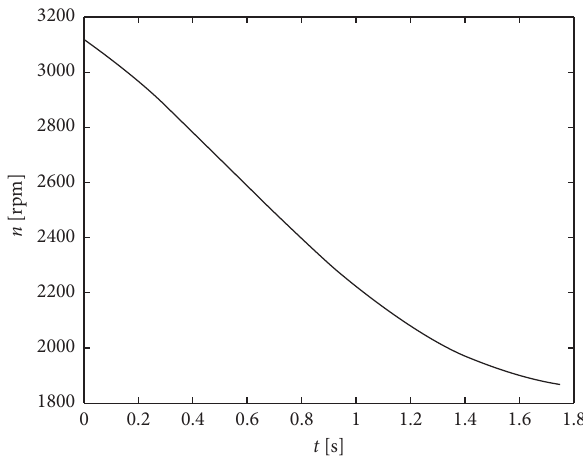
Figure 8: The simulation model of time-varying